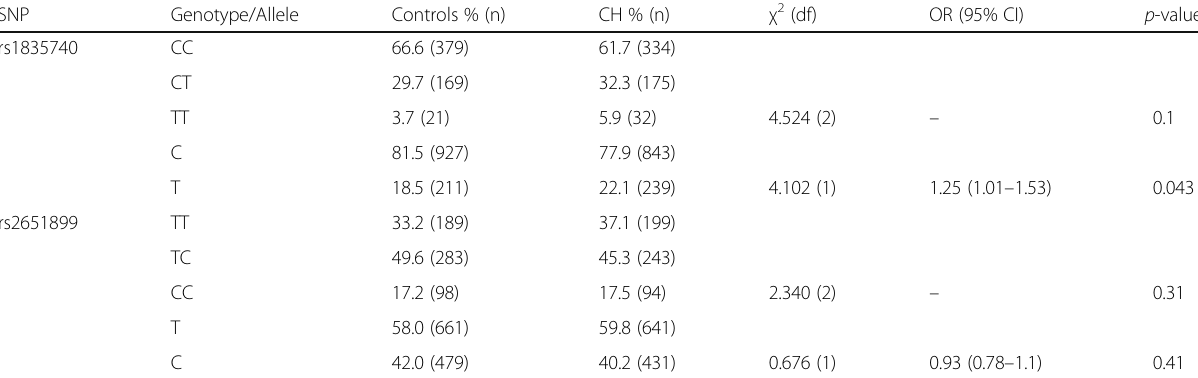
Table 1 Results from the genotype and allele analysis SNP